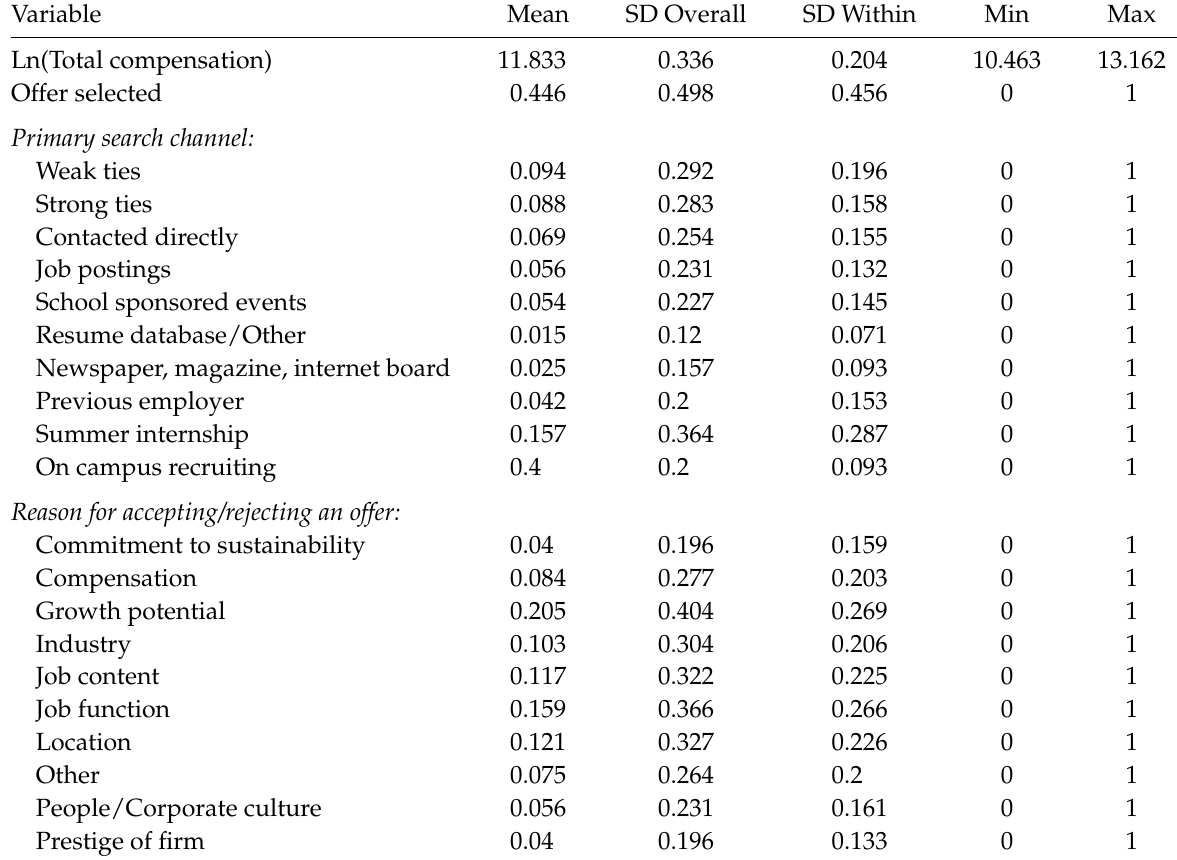
Table 1: Summary Statistics of Variables Used in Conditional Fixed Effects Models